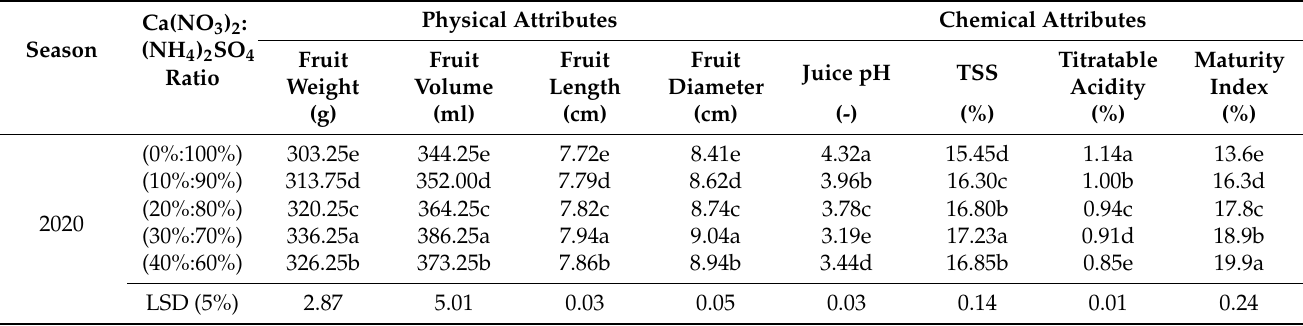
Table 3. Impact of Ca(NO 3 ) 2 :(NH 4 ) 2 SO 4 ratios on the physico-chemical attributes of the pomegranate fruits of cv. ‘Wonderful’ in 2020 and 2021